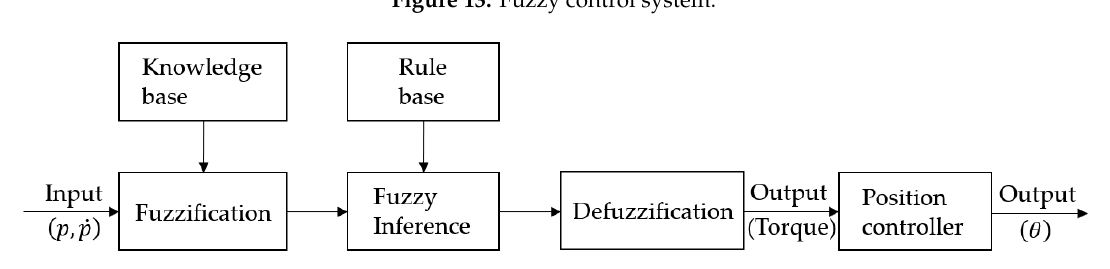
Figure 14. Fuzzy control system.